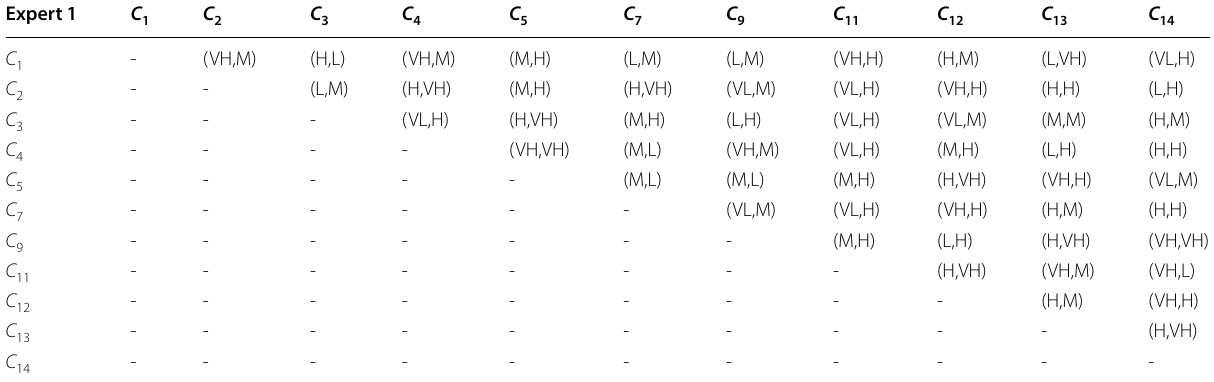
Table 3 Adjacency matrix expert opinion number 1 in the form of Z-numbers Expert 1